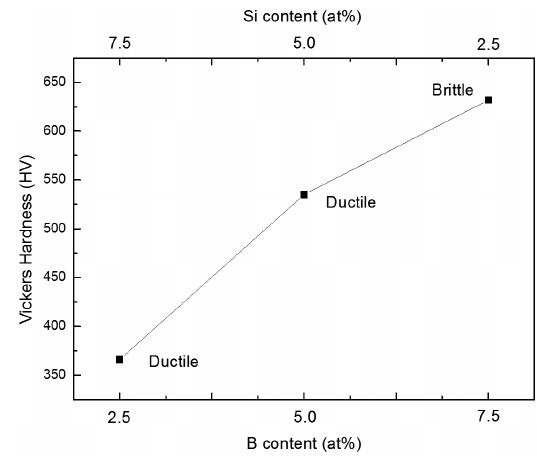
Figure 5. Compositional dependence of Vickers Hardness and bending ductility for the alloy at the same total metalloid content of Fe Si B (x=2.5, 5, 7.5). 90 x 10-x